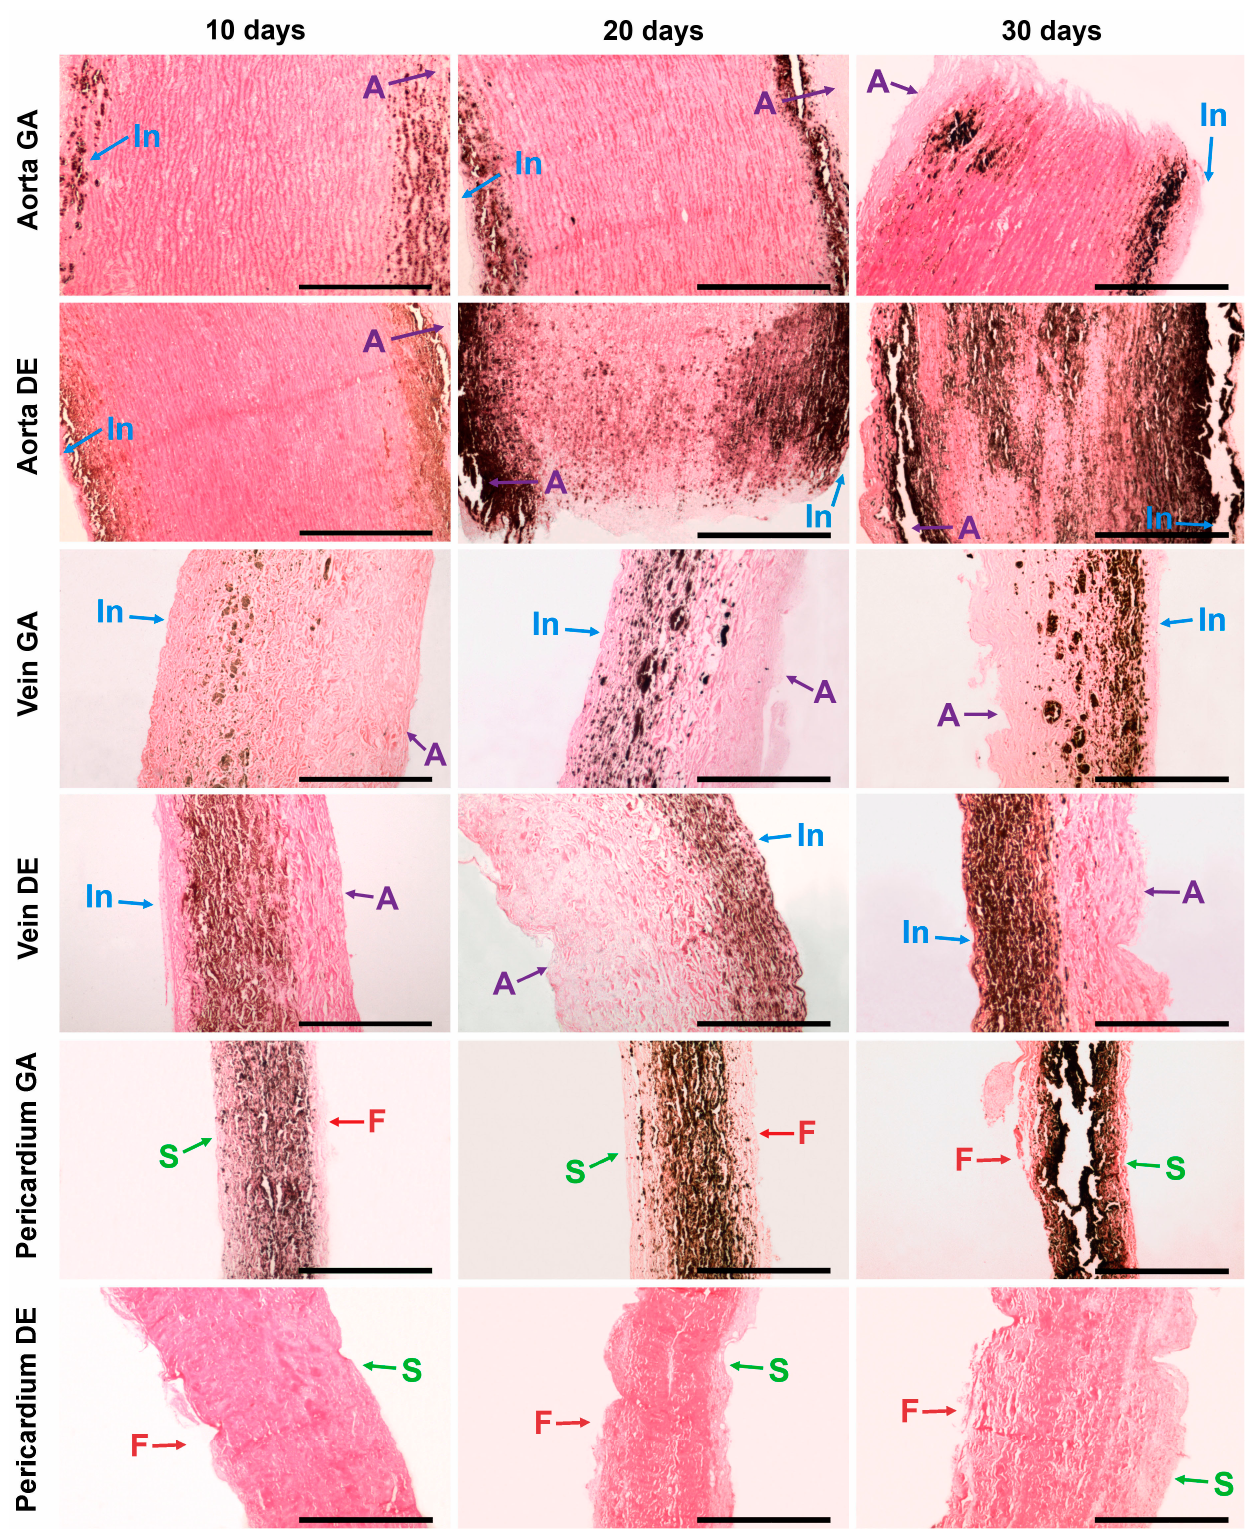
Figure 2. Calcium phosphate deposits in biomaterials 10, 20, and 30 days after implantation. Arrows show direction to surfaces: I—intimal; A—adventitial; S—serous; F— fi brous. No sign of calci fi cation show direction to surfaces: In—intimal; A—adventitial; S—serous; F—fibrous. No sign of calcification in DE-Pe. Scale bars 550 µm. in DE-Pe. Scale bars 550 µ